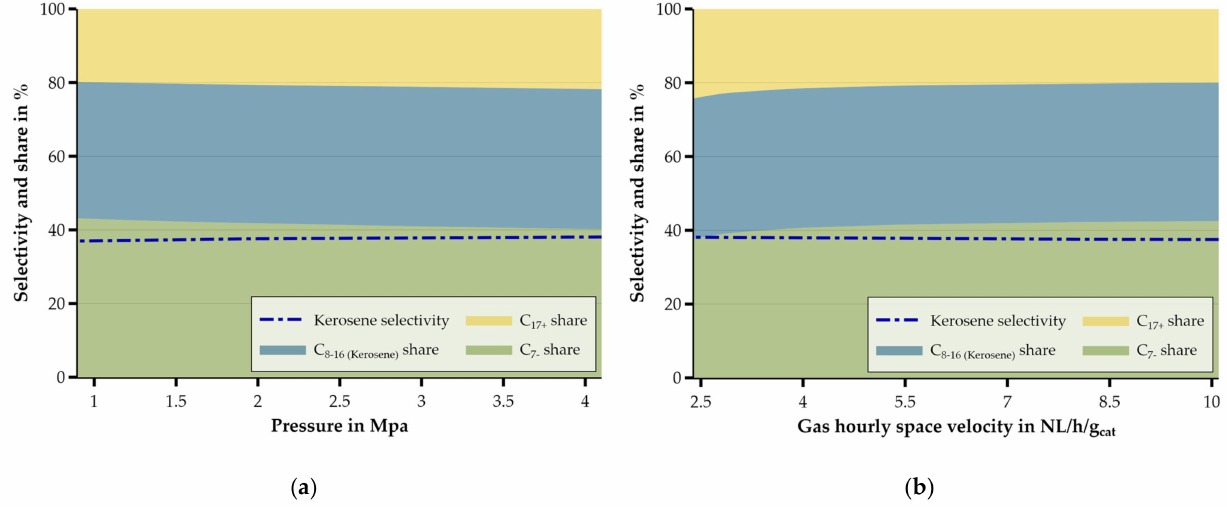
Figure 5. Reactor selectivity shares of different carbon chain length ranges and the kerosene range selectivity on the basis of the model showing ( a ) the pressure-dependency for a fixed bed reactor with T = 220 ◦ C, GHSV = 5 NL/h/g cat , and H2/CO syngas feed ratio = 2; and ( b ) the dependency from the GHSV for a fixed-bed-reactor with T = 220 ◦ C, p = 2.5 MPa, and H2/CO syngas feed ratio =